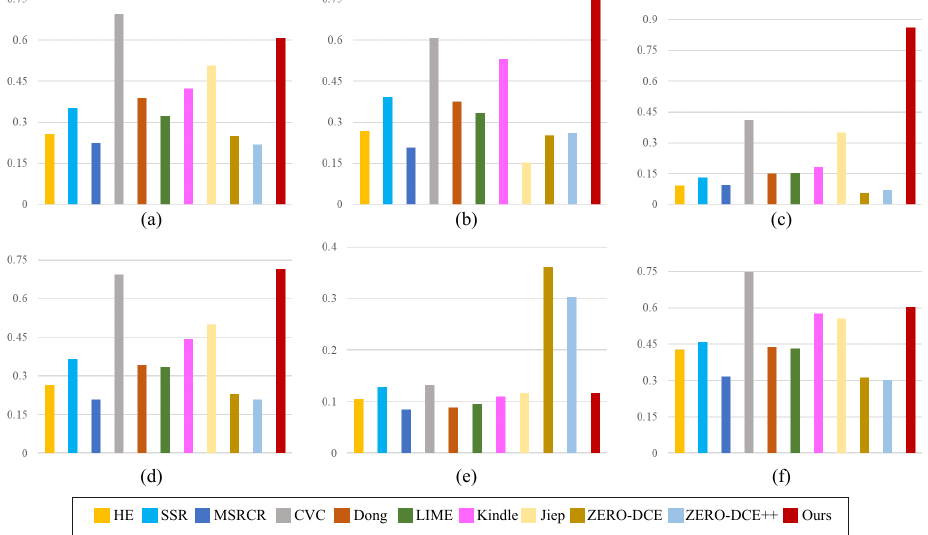
Figure 8. Quantitative comparisons in terms of SSIM. ( a ) LIME [28], ( b ) DICM [11], ( c ) LOL [14], ( d ) MEF [31], ( e ) NPE [32], ( f )